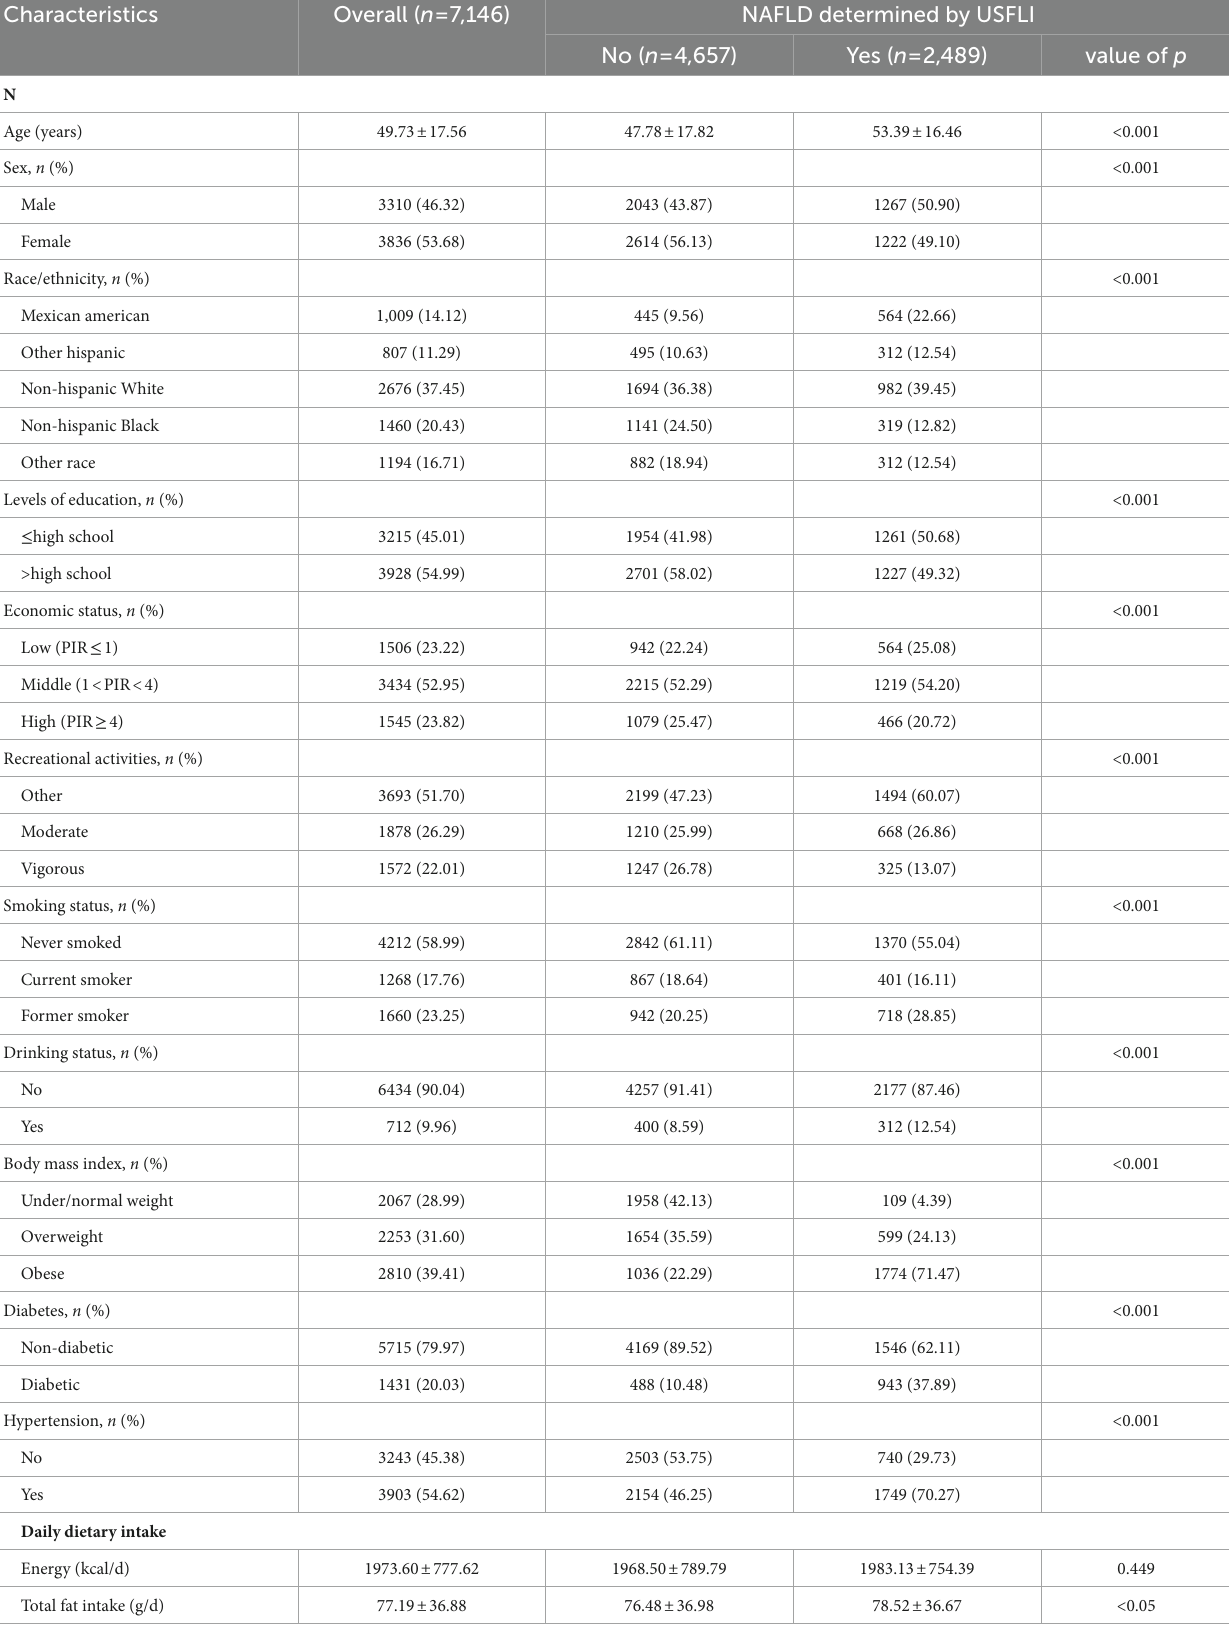
TABLE 1 Population characteristics by the presence or absence of NAFLD determined by USFLI in NHANES 2011–2018.